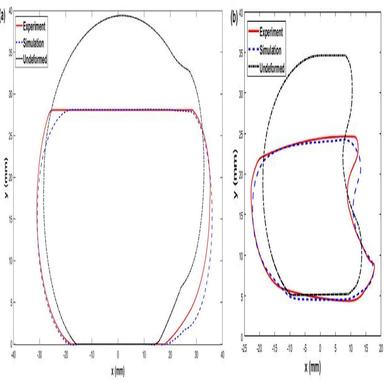
The boundaries of (a) whole organ and (b) CC under the 90-degree compression test and comparing the FE simulation results to experiments (normalised displacement=0.3).